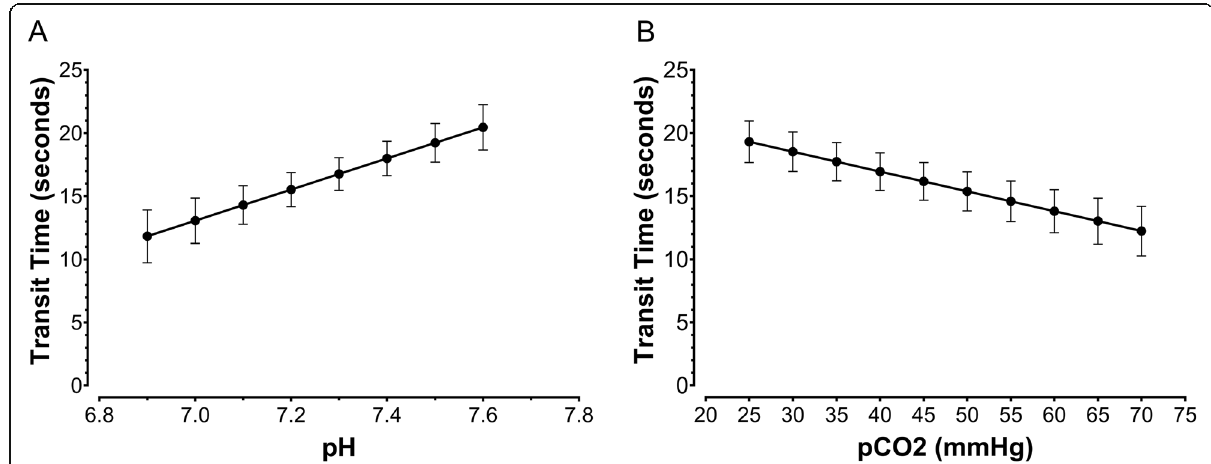
Fig. 5 Relationship between representative brain perfusion parameters and serum laboratory values (n = 20 experiments). Predictive margins following mixed effects linear regression analyses of brain perfusion parameters and serum laboratory values from ex utero contrast-enhanced ultrasound examinations were plotted for a , transit time and pCO2 and b , transit time and pH. Error bars show the standard